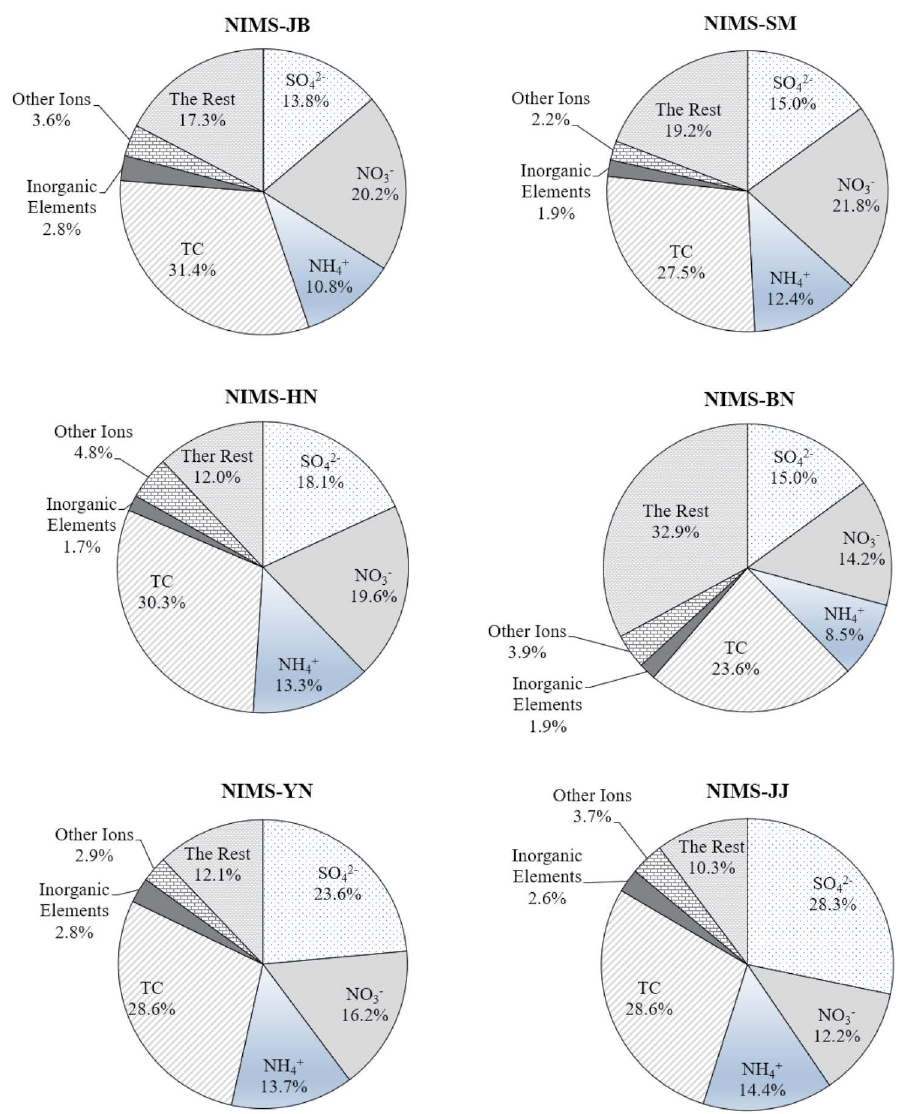
Fig. 9. Average chemical compositions in PM